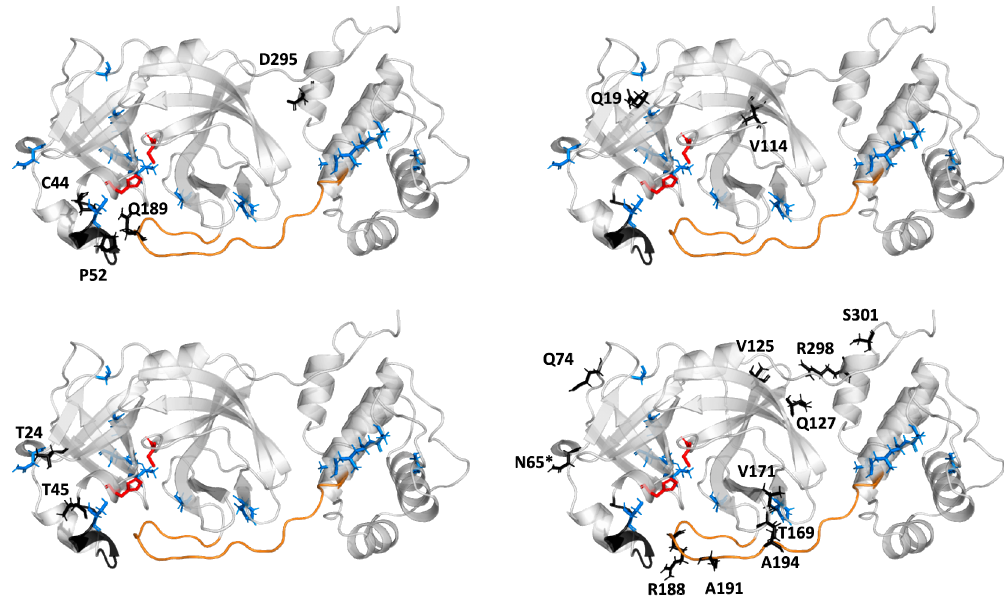
Figure 5. Localisation of the evolutionary-correlated residues of Mpros (black sticks). The correlated mutation analysis (CMA) analysis provided four groups of evolutionary-correlated residues. The SARS-CoV-2 Mpro structure is presented as a cartoon, the active site residues are shown as red sticks, the unique residues of the SARS-CoV-2 Mpro as blue sticks, and the asterisk (*) indicates the residue belonging to the evolutionary-correlated residues, unique for SARS-CoV Mpro. The loop C44-P52 is coloured black and the F185-T201 loop is orange. Please note that within one of the correlated groups (upper left), the residues from C44-P52 loop are correlated with Q189 from the linker loop and with residue from III domain.